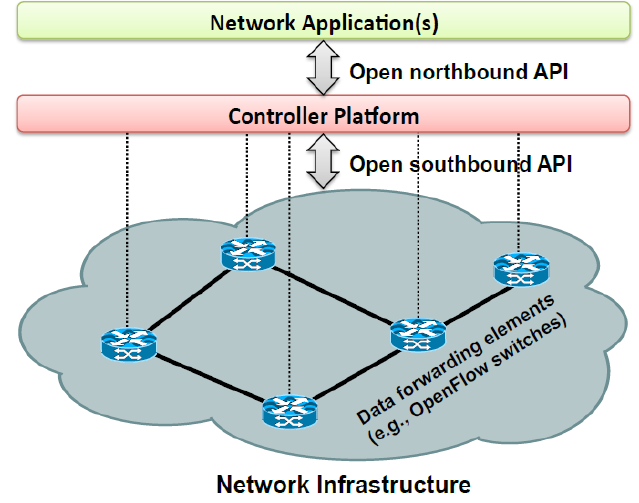
Figure 1. Structure of a software defined network (SDN).